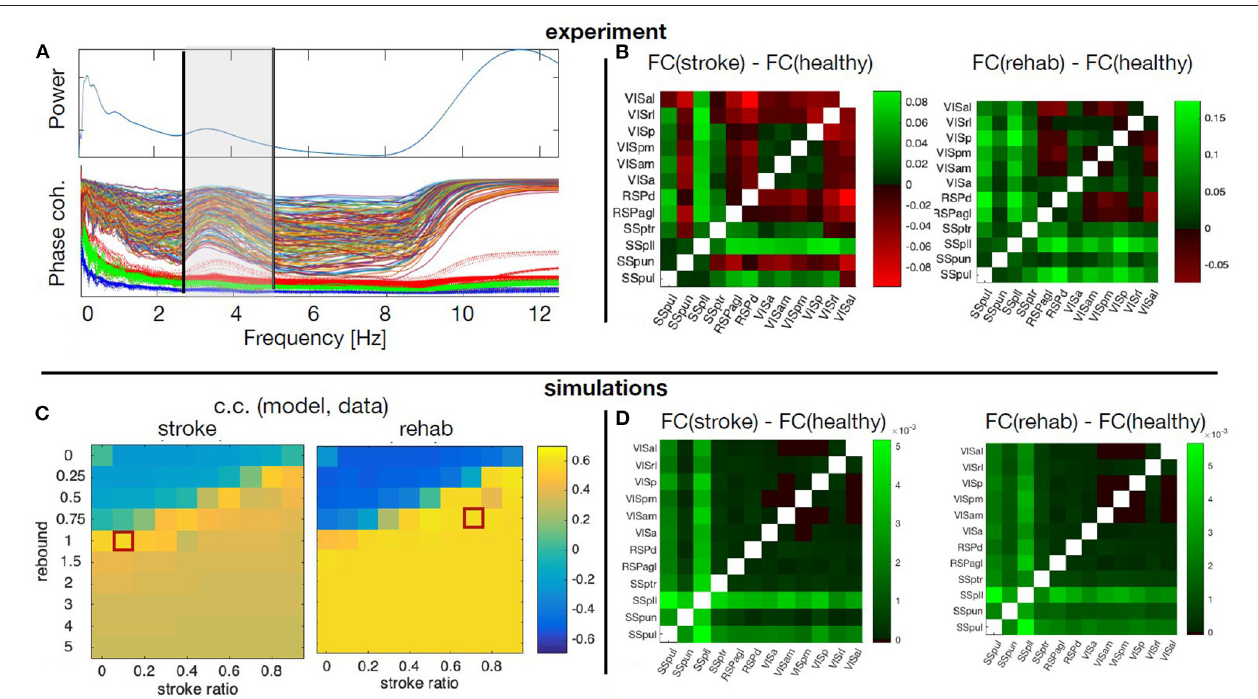
FIGURE 9 | Simulated and empirical Functional connectivity and fitting the model. (A) Average power spectrum across the regions and the PLV values for each pair of regions (thin lines) during healthy state, as well as the significance levels from the surrogates (thick dotted lines). Vertical black lines show the boundaries of the upper δ band. (B) Relative changes of the FC at stroke and at rehabilitation compared to the healthy control for frequency band f = 2.5 − 5 Hz . (C) Cross correlation of the model upper triangles of FC between the model and the data for fixed global coupling K = 4.3 and different levels of stroke (0 for complete damage and 0.9 for damage of 10 % of the links) and rebound connectivity (0 for no rewiring and 5 for overall rewiring with strength of 5 times of the damaged links). Parameters: frequency f = 2 Hz , noise strength D = 1. (D) Simulated relative changes of the FC at stroke and rehabilitation relative to the healthy control for the working points marked with red squares in the parameters space in the panel (C) . The abbreviations for the areas in (B,D) are: VIS, visual; RSP, retrosplenial; SS, somatosensory; al, anterolateral; rl, rostrolateral; p, primary; pm, posteromedial; am, anteromedial; a, anterior; d, dorsal; agl, lateral agranular part; ptr, primary trunk; pll, primary lower limb; pun, primary unassigned; pul, primary upper